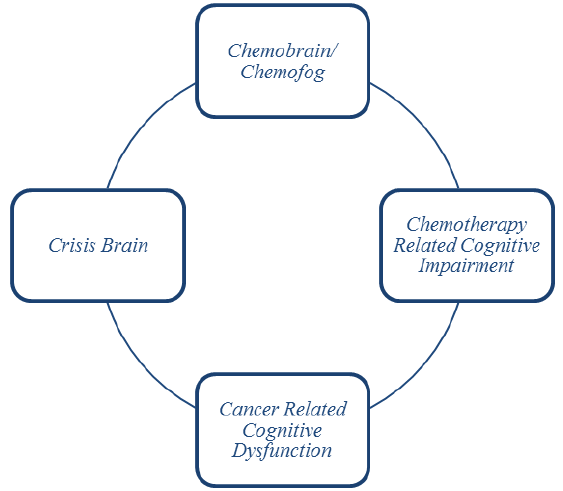
Figure 1. The evolution of the concept denominating the cognitive dysfunctions resulting from anti-cancer